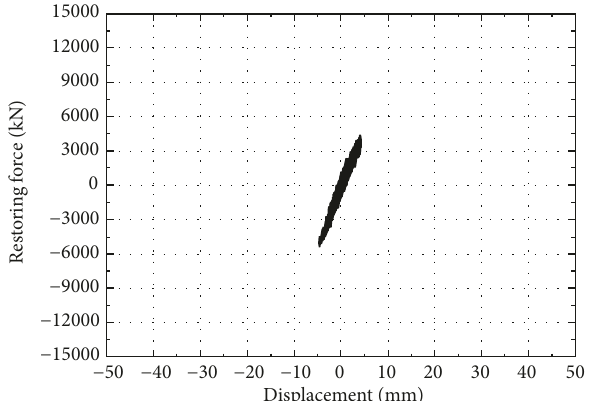
Figure 28: Hysteresis curve of intensity 7 rarely of synthesized (longitudinal